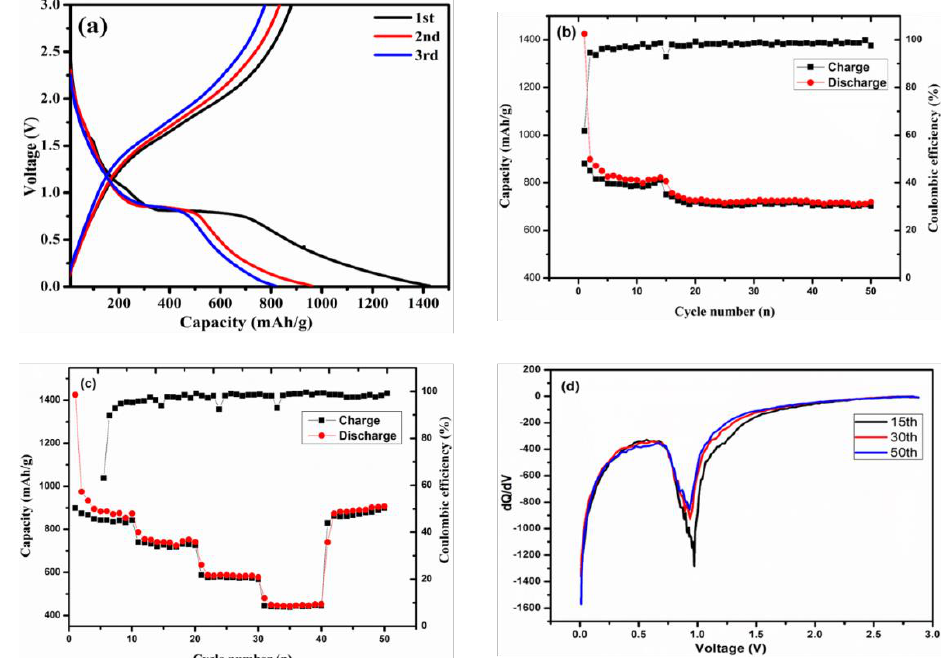
Figure 6. ( a ) Discharge–charge curves of RGO/Fe 3 O 4 at a current density of 200 mA/g; ( b ) cycling performance of Fe 3 O 4 /RGO at a current density of 200 mA/g; ( c ) rate capacities of Fe 3 O 4 /RGO at 200–1500 mA/g; ( d ) differential plots of capacity vs. cell voltage.